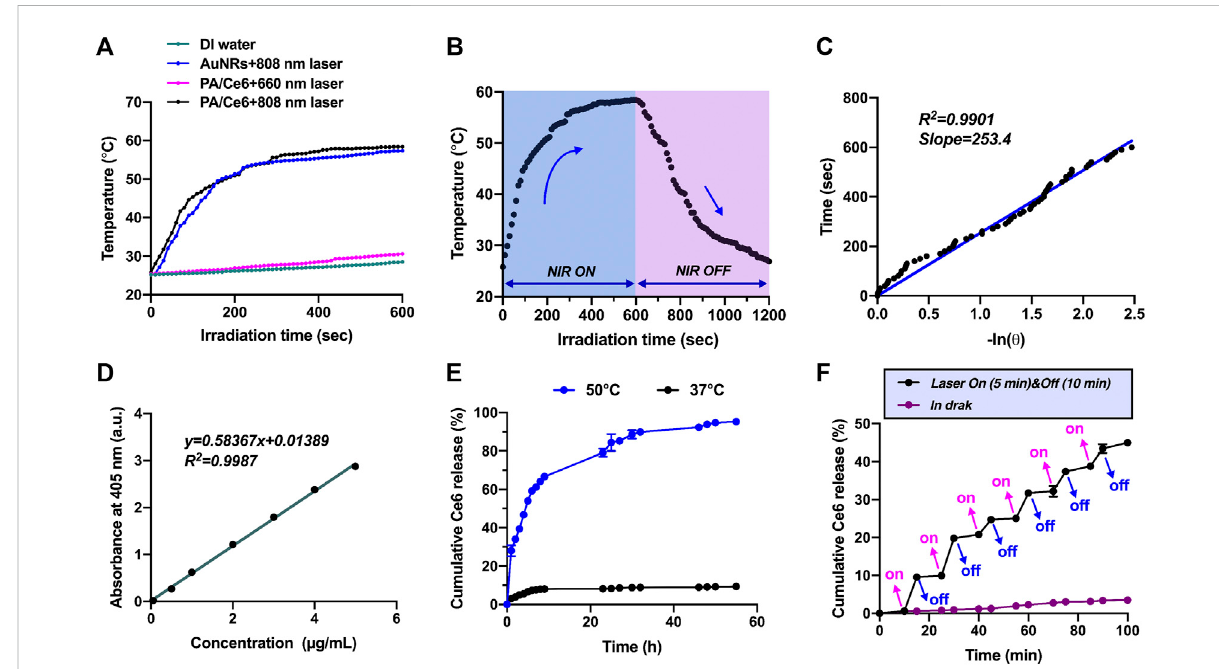
FIGURE 2 (A) Temperature change curves of PBS, AuNRs, and PA/Ce6 solution under NIR laser irradiation at 860 and 660 nm, (B) temperature curves of PA/Ce6 solution in one single on/off process of NIR laser irradiation, (C) association of cooling time with the negative natural logarithm of temperature driving force after turning off NIR laser, (D) standard solution curve of Ce6, (E) cumulative Ce6 release curves of PA/Ce6 in PBS (pH 7.4) at 37 ° C and 50 ° C, and (F) Ce6 release curve of PA/Ce6 over 100 min under the cycles of NIR laser on/off. For each experiment, three independent repetitions were conducted in this study. * indicates a p value of < 0.05; ** indicates a p value of <